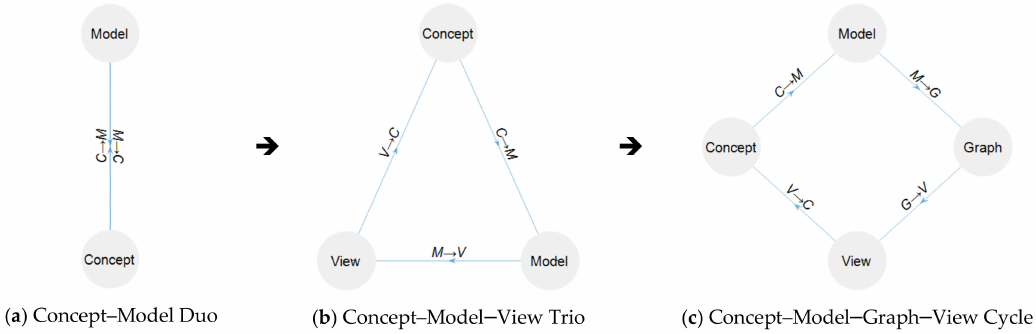
Figure 1. ( a ) The Model ⇔ Concept duo extended to ( b ) Model → View → Concept trio extended as a ( c ) Concept → Model → Graph → View Cycle